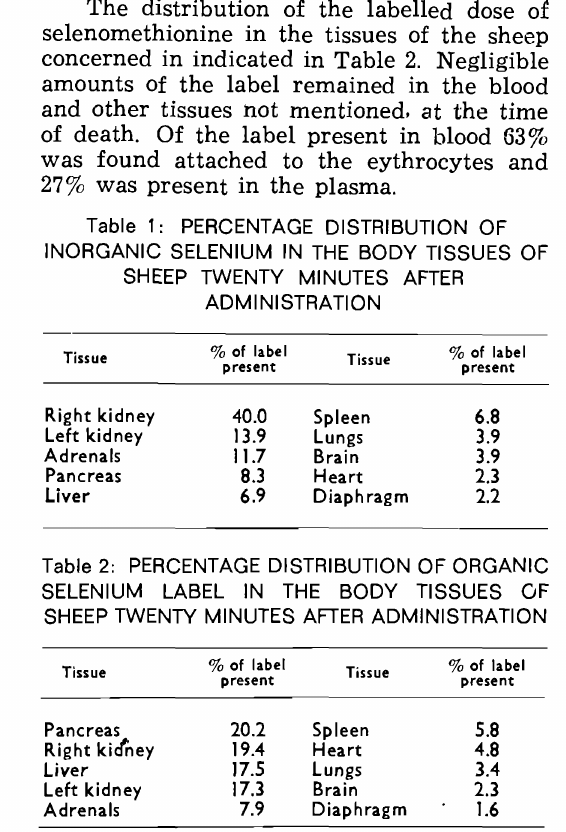
Table 1: PERCENTAGE DISTRIBUTION OF